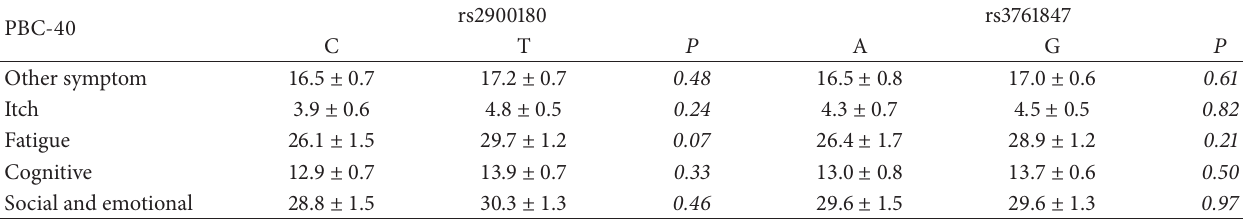
Table 7: Allelic analysis (C versus T and A versus G) of rs 2900180 and rs 3761847, respectively, in relation to PBC-27 domains. PBC-27 Other symptom